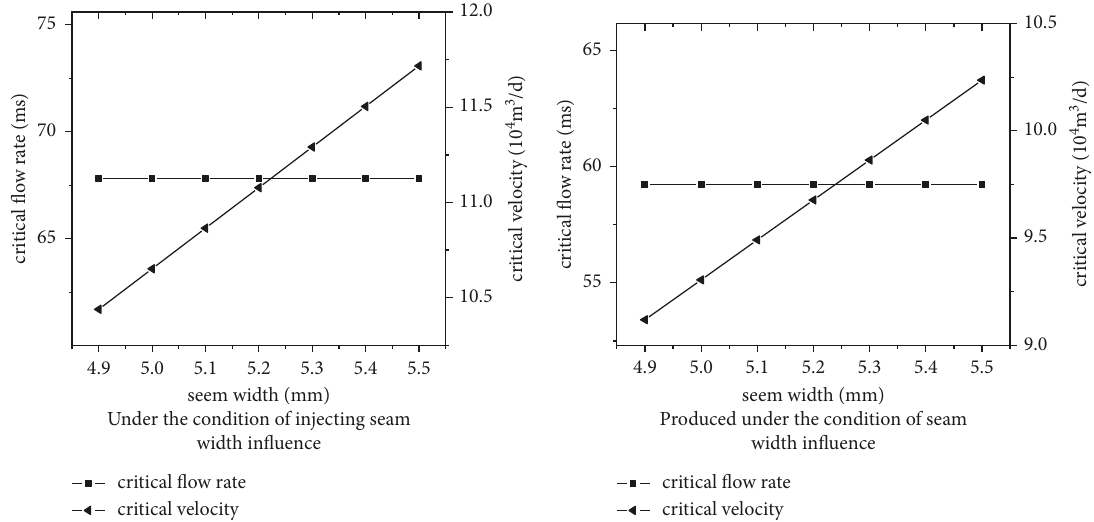
Figure 5: Influence diagram of fracture width under injection-production conditions.